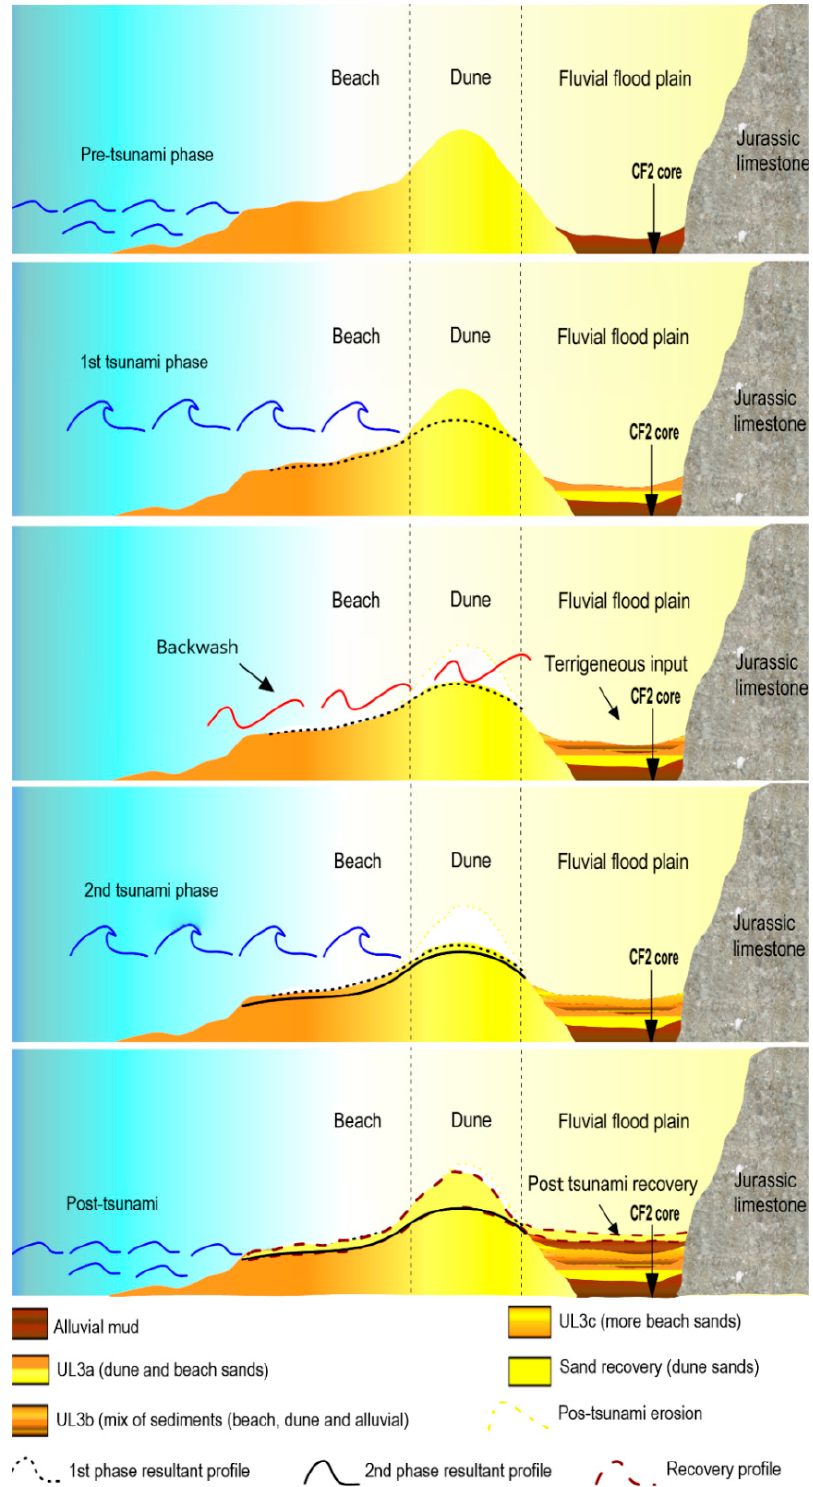
Figure 7. Conceptual model of tsunami inundation and sediment source deposition.